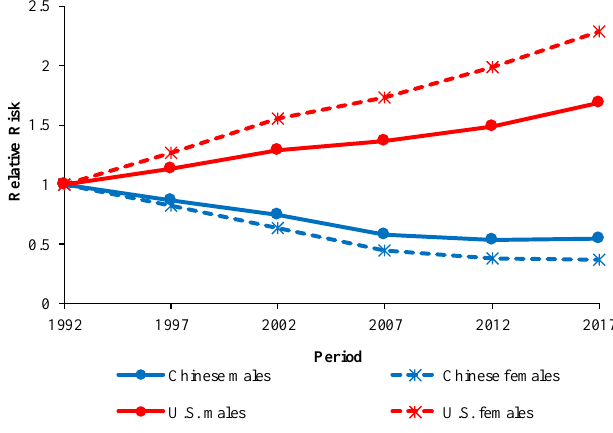
ff ects on COPD mortality by sex in China and the Figure 6. Period effects on COPD mortality by sex in China and the U.S. Figure 6. Period e Figure 6. Period effects on COPD mortality by sex in China and the U.S.